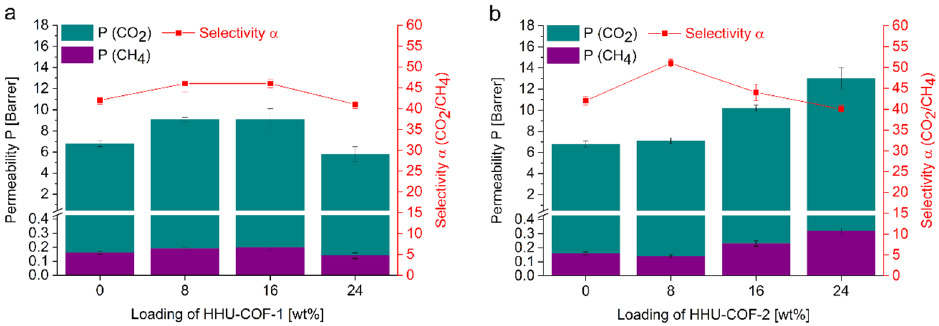
Figure 8. CO 2 and CH 4 permeabilities ( P ) and CO 2 /CH 4 selectivity(α) for ( a ) HHU-COF-1/Matrimid and ( b ) HHU-COF-2/Matrimid and ( b ) HHU-COF-2/Matrimid MMMs.